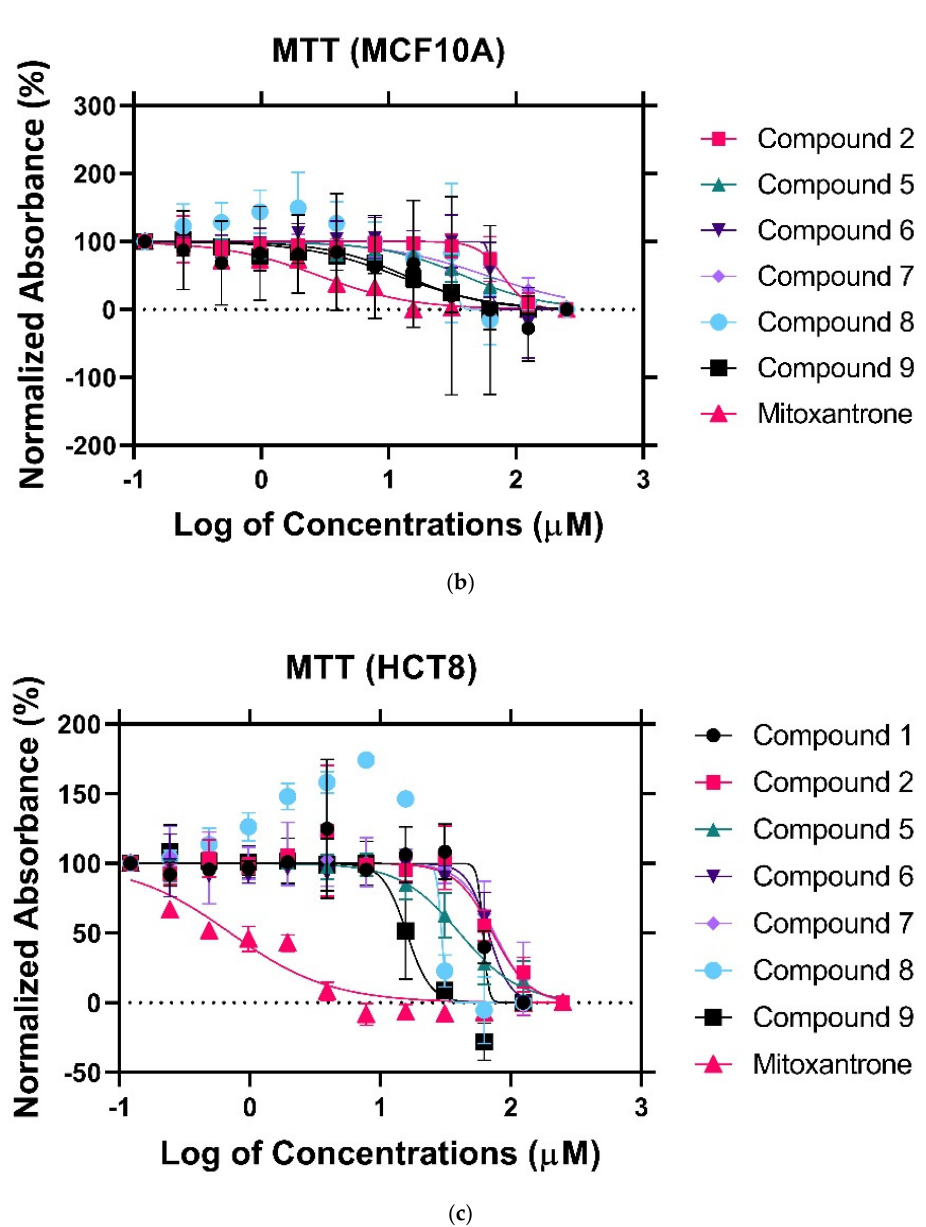
Figure 3. MTT assay of the fourteen (14) synthetic compounds against ( a ) MDA − MB − 321 cancer cell lines, ( b ) MCF10A cell lines, ( c ) HCT8 cancer cell lines.